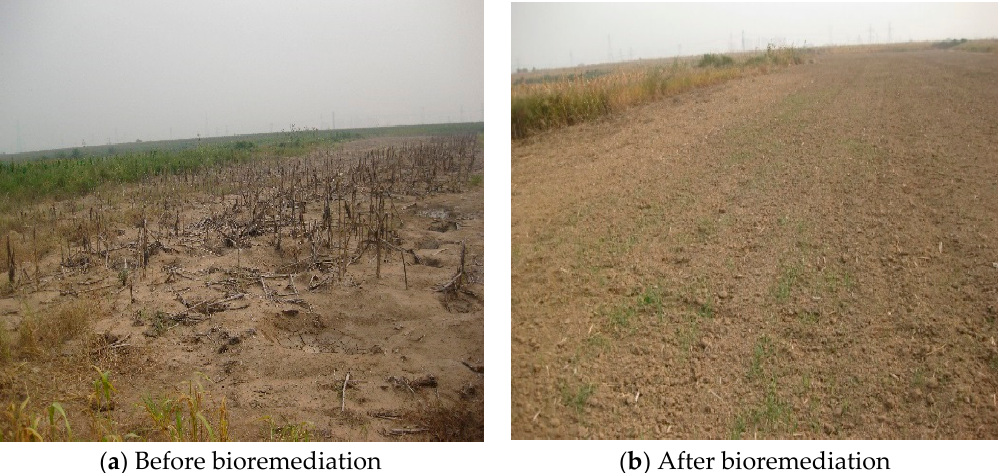
Figure 5. Picture of the contaminated filed.